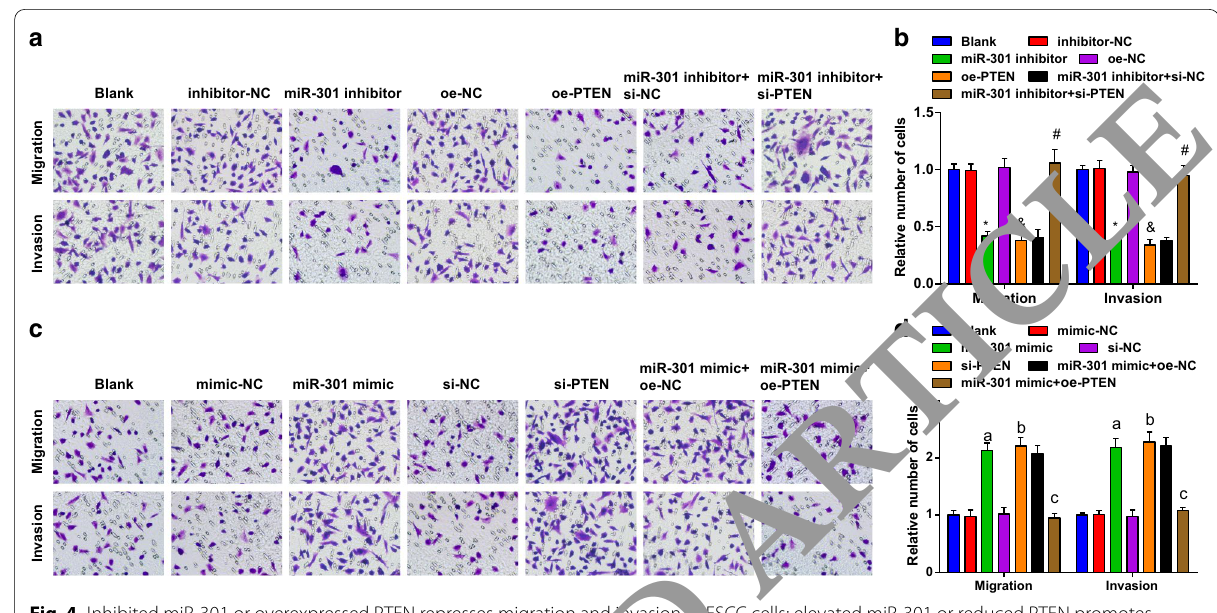
Fig. 4 Inhibited miR-301 or overexpressed PTEN represses migration and invasion of ESCC cells; elevated miR-301 or reduced PTEN promotes migration and invasion of ESCC cells. a Migration and invasion abilities of transfected KYSE-30 cells assessed using Transwell assay after miR-310 downregulation or PTEN upregulation; b statistical results of migrated and invasive in KYSE-30 cells through Transwell assay after miR-310 downregulation or PTEN upregulation; c migration and invasion abilities of Eca109 cells among the groups assessed using Transwell assay after miR-310 upregulation or PTEN downregulation; d statistical results of migrated and invasive in Eca109 cells through Transwell assay miR-310 upregulation or PTEN downregulation. * P < 0.05 versus the inhibitor-NC group; & P < 0.05 versus the oe-NC group; # P < 0.05 versus the miR-301 inhibitor si-NC group; a P < 0.05 versus the mimic-NC group; b P < 0.05 versus the si-NC group; c P < 0.05 versus the miR-301 mimic + N 3. Data were expressed as mean standard deviation, and ANOVA was used for comparisons among multiple = ±